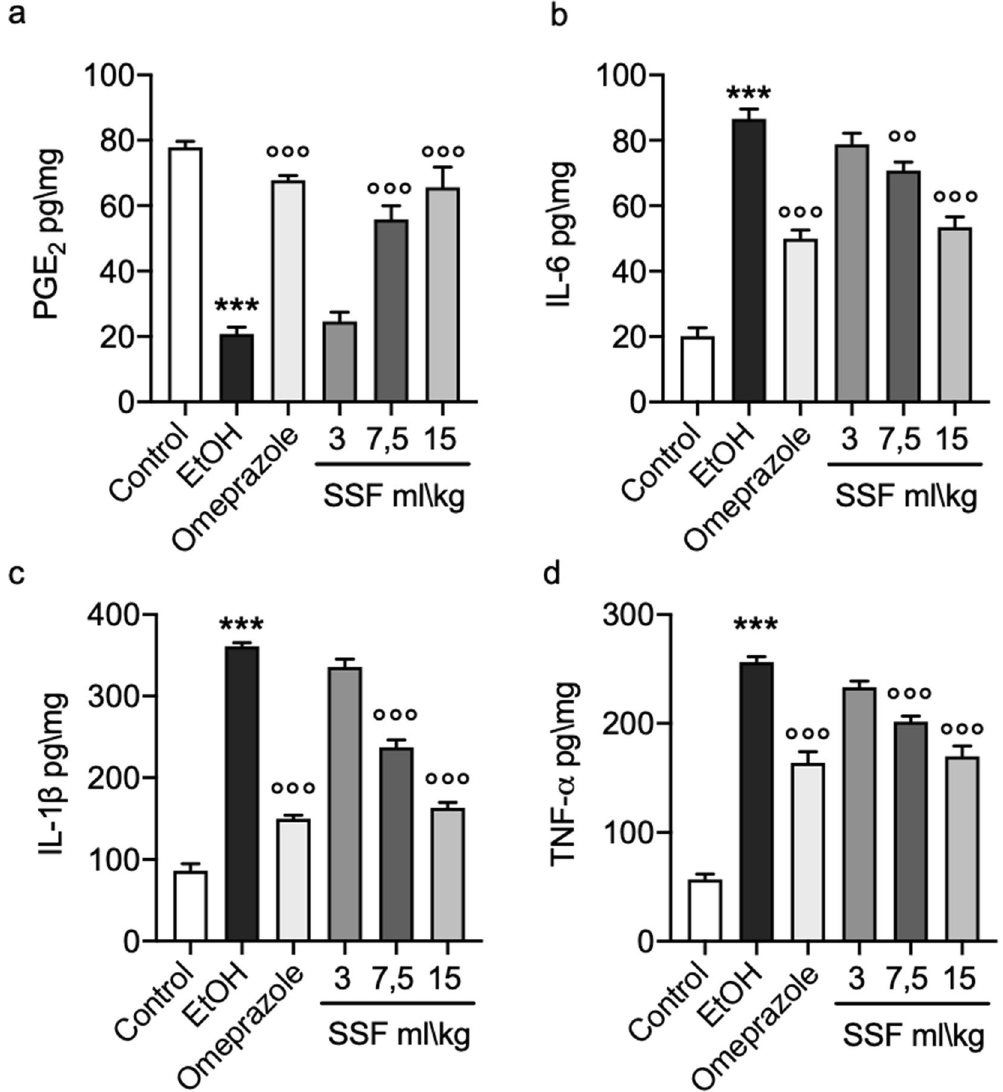
Figure 7. ELISA assays for ( a ) PEG 2 ; ( b ) IL-6; ( c ) IL-1β; ( d ) TNF-α . Data are presented as means ± SEM of 10 mice for each group; ***p < 0.001 versus control; ◦◦ p < 0.01 versus EtOH; ◦◦◦ p < 0.001 versus